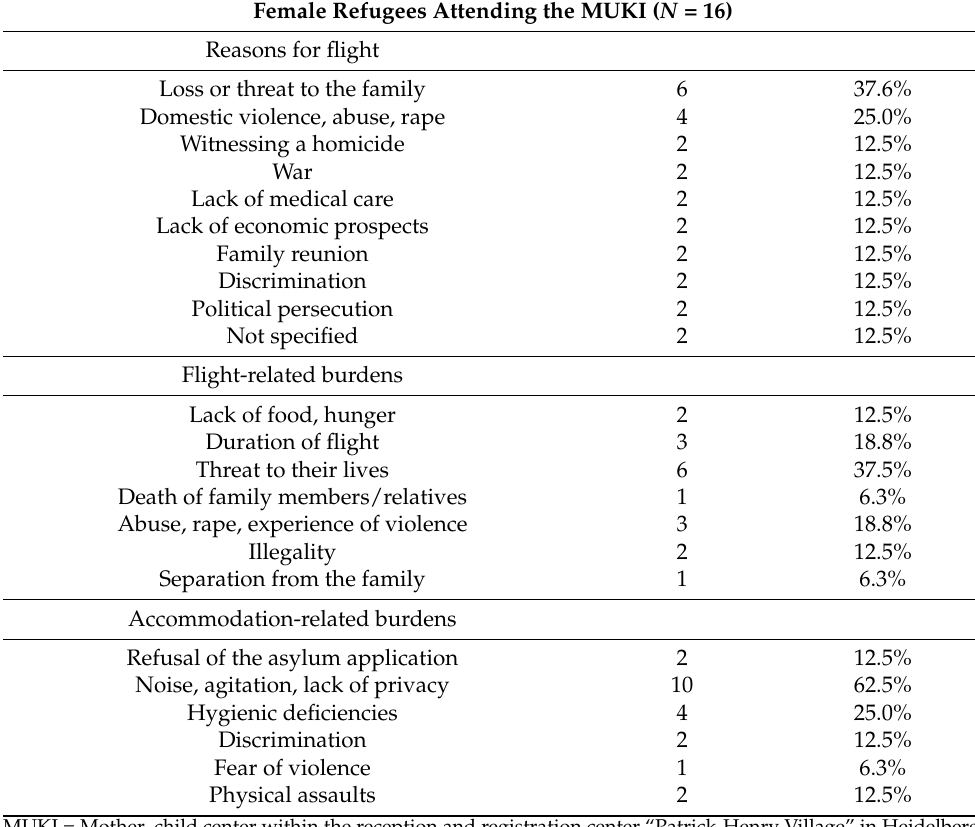
Table A2. Further sociodemographic data of interviewed female refugees attending the MUKI ( N =